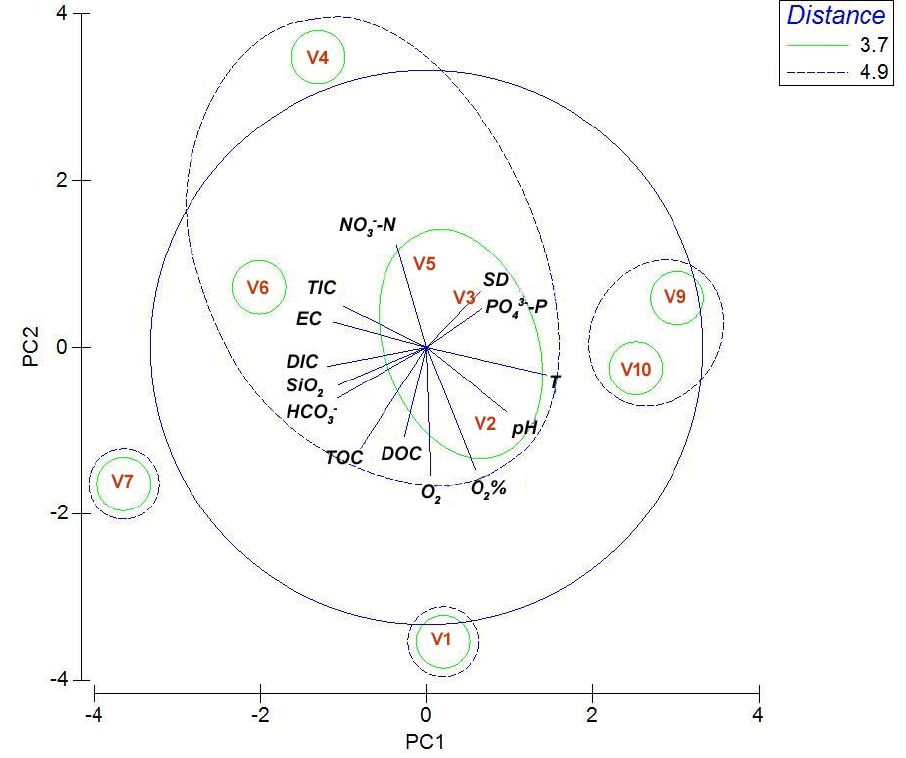
Figure 2. Principal Component Analysis (PCA) ordination diagram performed on the environmen-